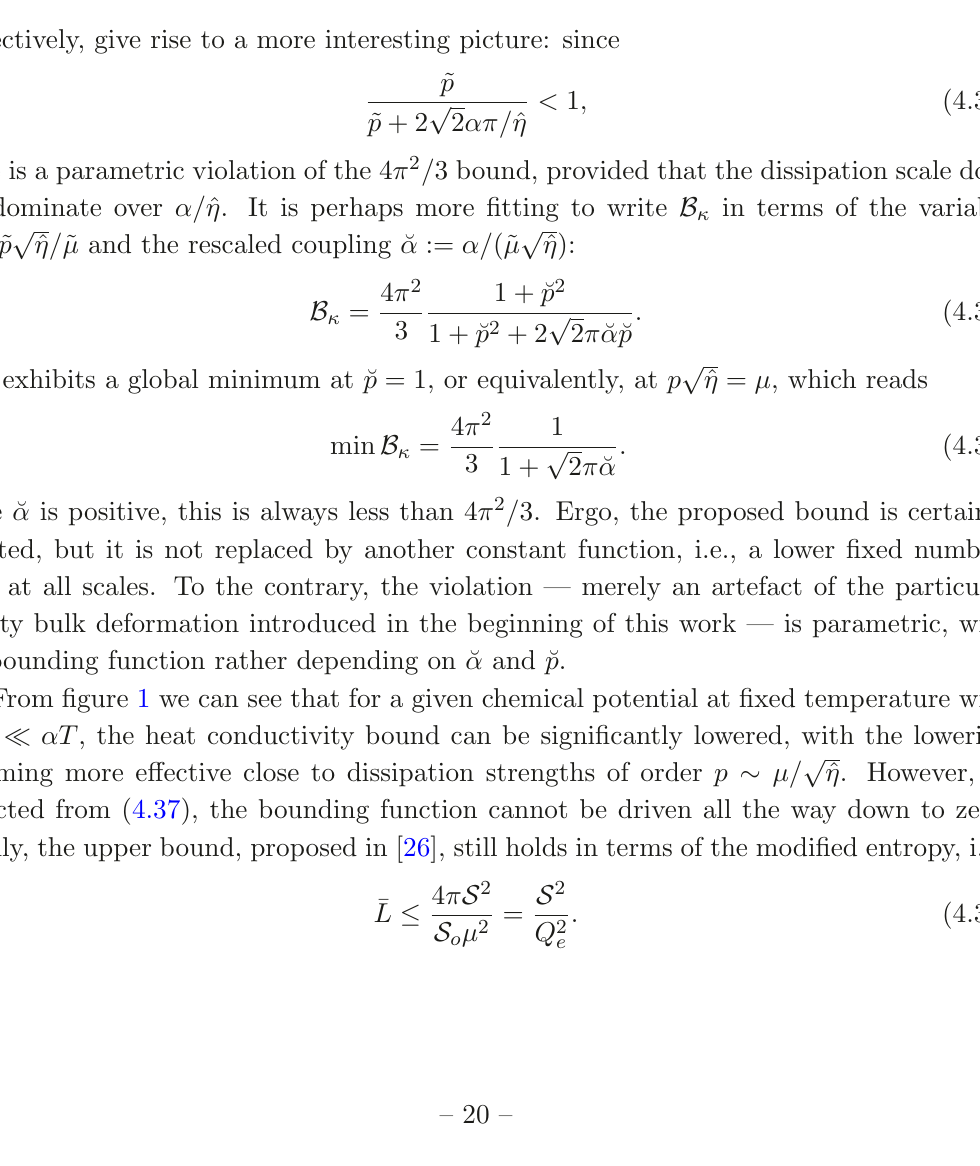
Figure 1 . The red line always indicates the 4 π 2 / 3 bound when ˘ α = 0 = α . The blue line is for ˘ α = 0 . 1, the yellow for ˘ α = 1, and the green for ˘ α =